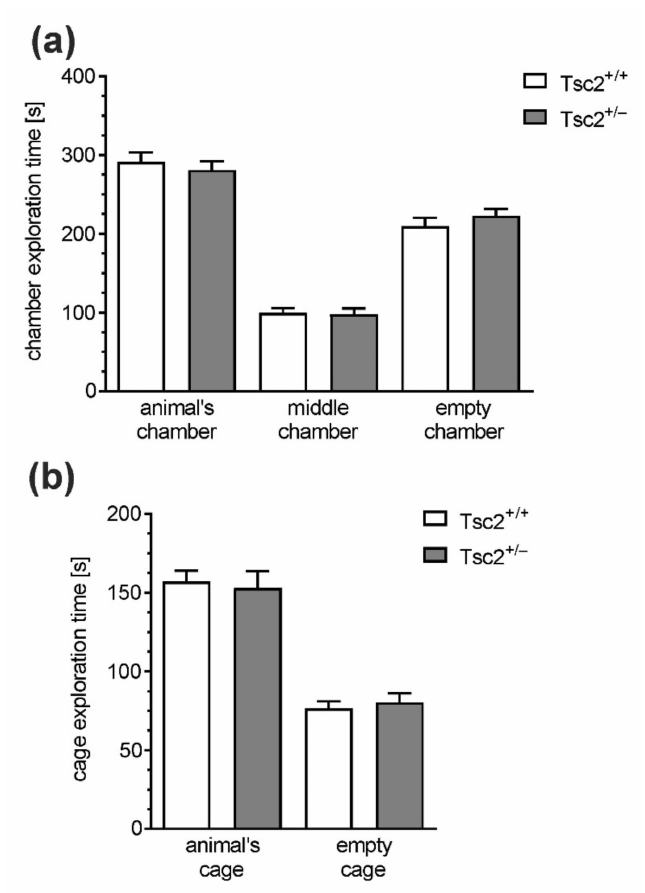
Figure 8. The effect of Tsc2 haploinsufficiency in mice on behaviour (sociability). ( a ) The time spent by the tested animal in the chamber; ( b ) the time spent by the tested animal on the exploration of cages. Data represent the mean values ± SEMs from n = 20 independent experiments. Each data point is from a separate animal.